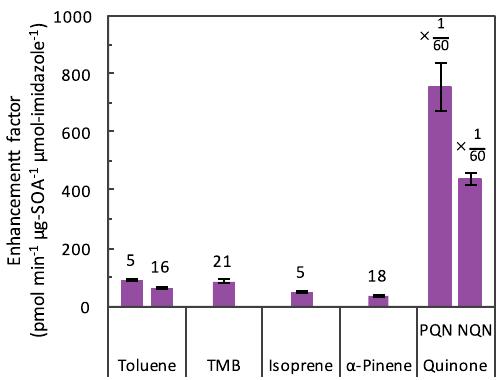
Figure 4. Enhancement factors (pmolmin − 1 µg-SOA − 1 µmol- imidazole − 1 ) of SOA in the presence of 2,4-dimethylimidazole. The label above each column represents the initial HC / NO x ra- tio. The enhancement factor is expressed as the mean ( ± σ) of three replicates. The enhancement factors of PQN and NQN are divided by